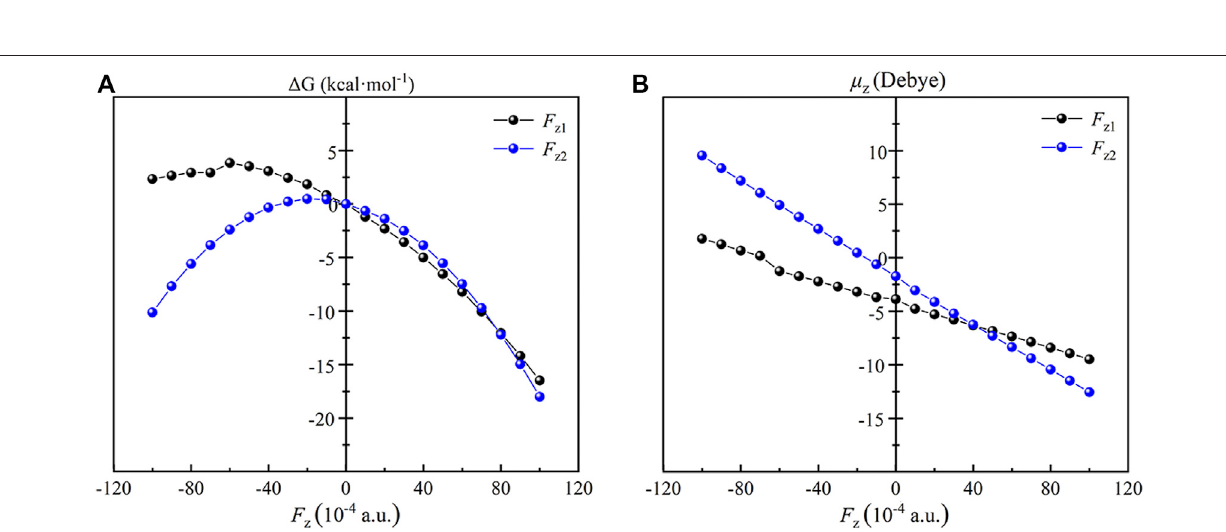
Frontiers in Chemistry |